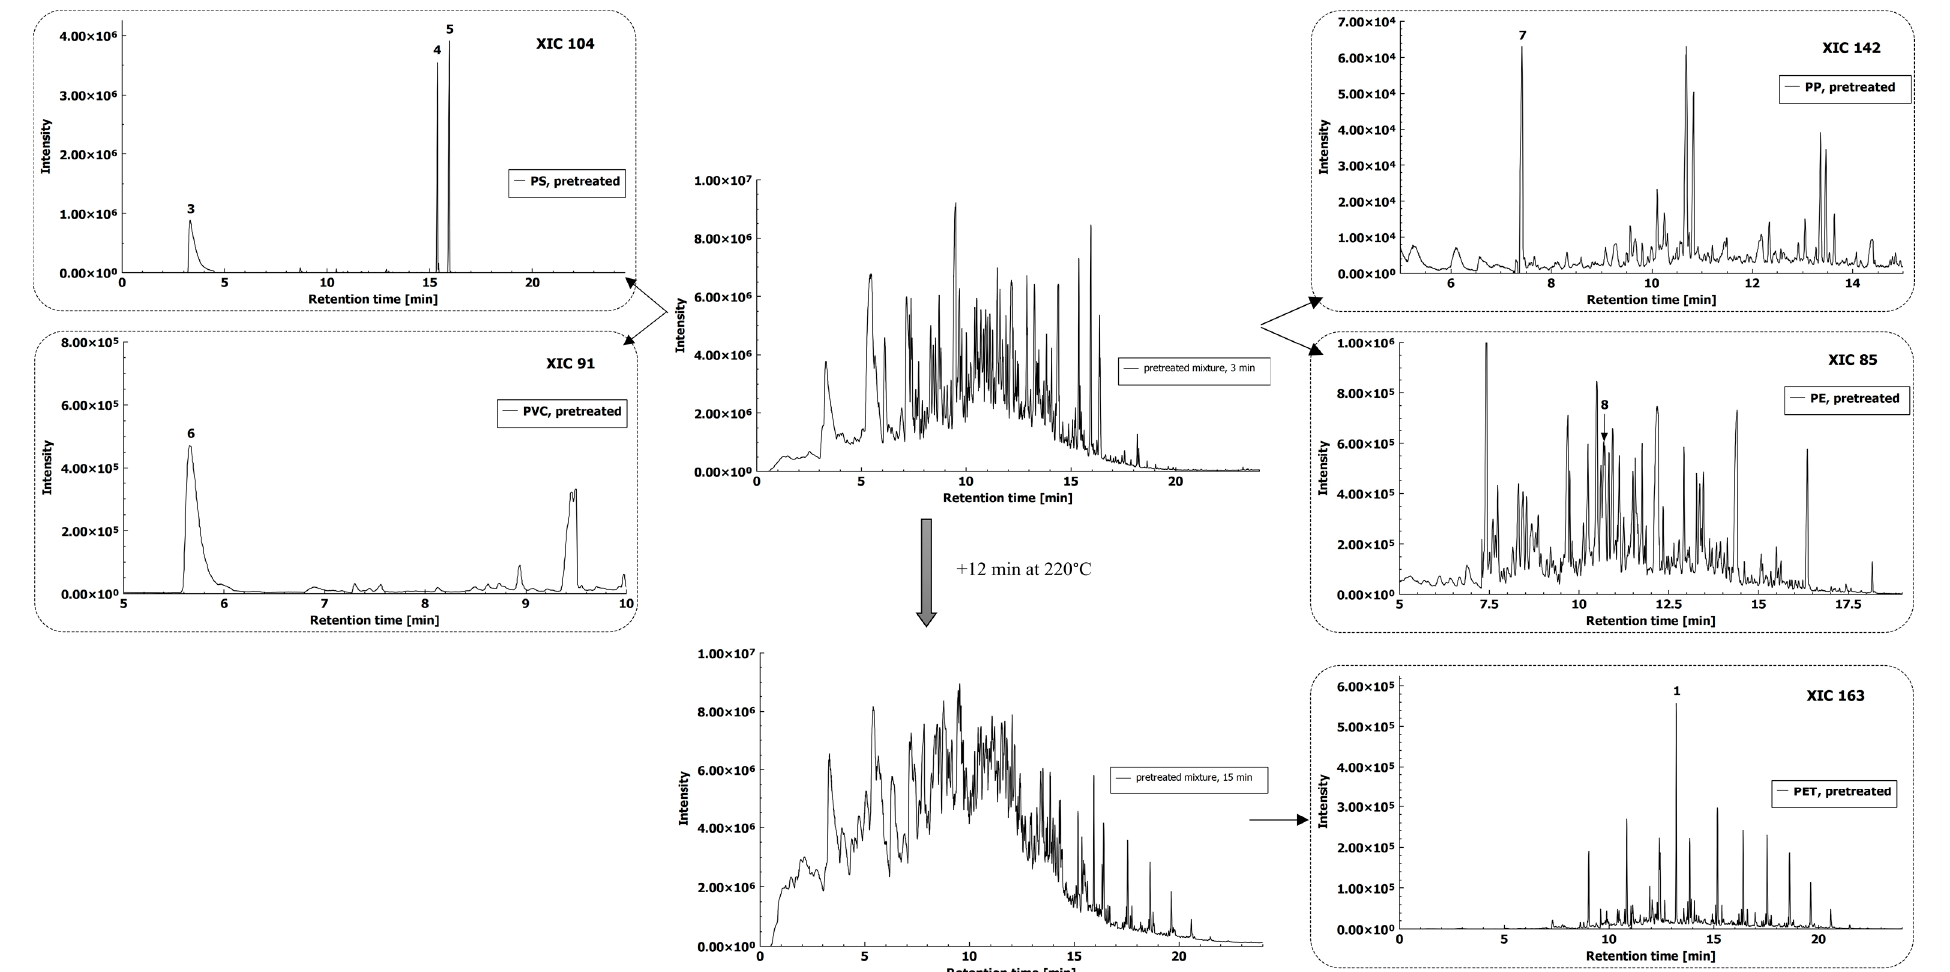
Figure 7. HS-SPME-GC–MS total ion chromatograms of MPs spiked microalgae and organic compost matrix after its pre-treatment and thermal decomposition at 220 °C for 3 min and 15 min with extracted ion chromatograms of identified polymers (polymer-specific compounds: 3–styrene, 4 and 5–trans (cis)-1,2-diphenylcyclobutane, 6–1-chlorooctane, 7–4,6-dimethyl 2-heptanone, 8–pentadecane, and 1–dimethyl terephthalate).